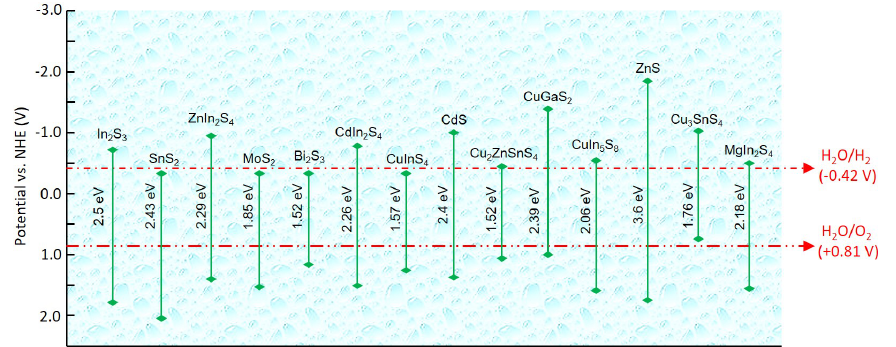
Figure 5. The band gap and band positions of the selected MS semiconductors, along with the needed oxidation and redox potential for water splitting. Data obtained from, In 2 S 3 [27], SnS 2 [28], ZnIn 2 S 4 [29], MoS 2 [30], Bi 2 S 3 [31], CdIn 2 S 4 [32], CuInS 2 [33], CdS [34], Cu 2 ZnSnS 4 [35], CuGaS 2 [36], CuIn 5 S 8 [37], ZnS [38], Cu 3 SnS 4 [39], MgIn 2 S 4